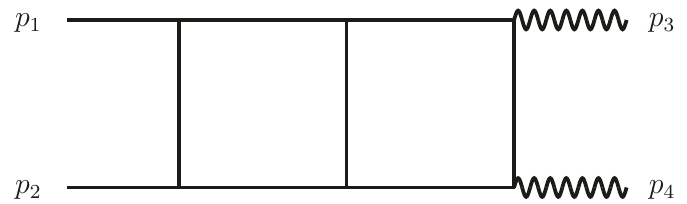
Figure 3 . Two loop graph of topology 1.